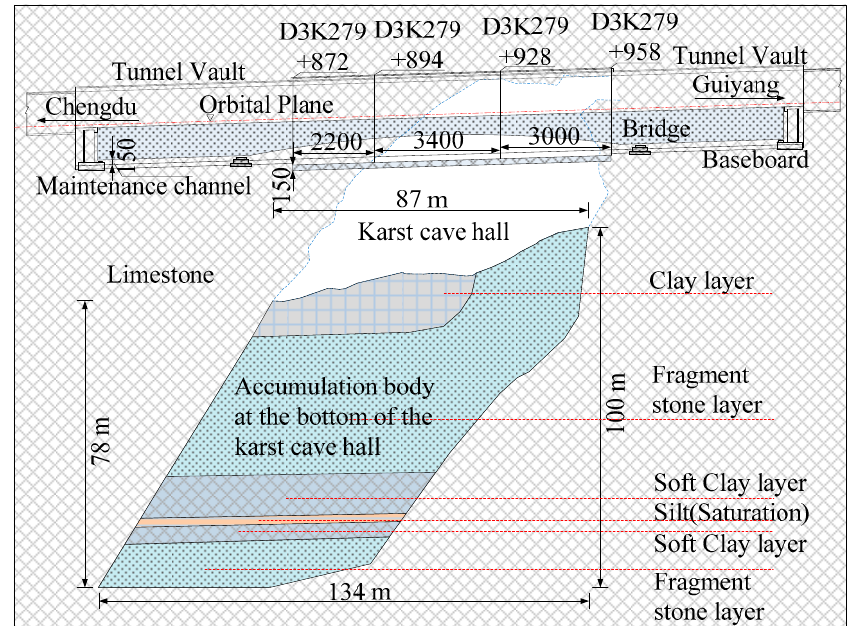
Figure 2. Geological profile of karst cave.